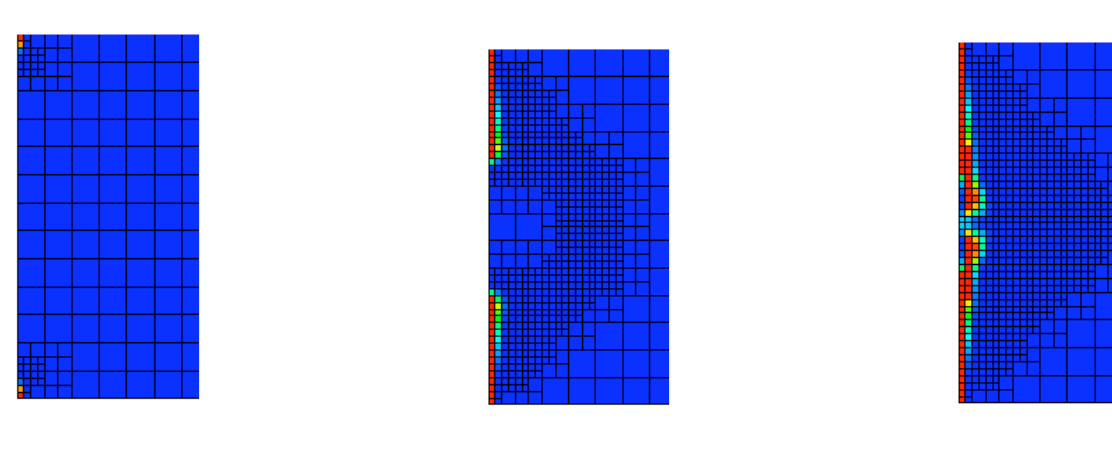
Figure 7 . Energy release rate based refinement, c = 0 . 5 : The same simulation as in Figure 6, but now with the refinement indicator parameter c = 0 . 5 . Note the difference in the mesh pattern, specifically the refinement of cells in which damage is not evolving.